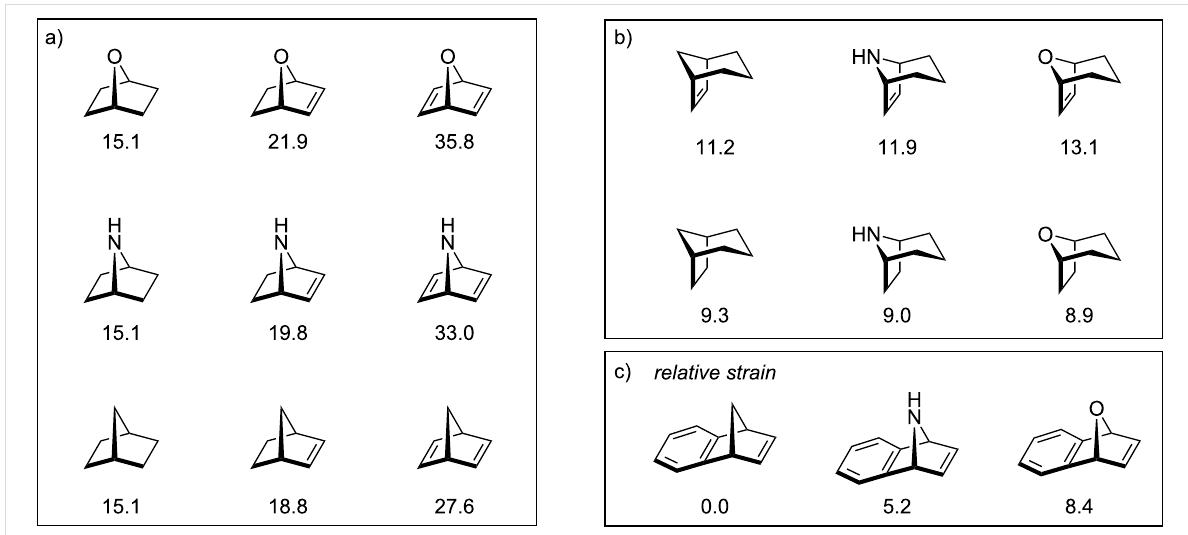
energy. Moreover, the introduction of a bridging heteroatom in- creases the ring-strain energy of the system, conceptualized by the decrease in bond distances. Typically, there are two modes for ring-strain release. First, functionalization of the double bond mildly alleviates the ring strain by relieving nonoptimal bond angles enforced by the rigid bicyclic framework. Second- ly, through ring opening of the bicyclic framework; the C–X bond of a heterobicyclic alkene is much weaker than the corre- sponding C–C bond of a homobicyclic alkene, which allows the C–X bond to be readily cleaved over the course of a reaction. The stereochemically well-defined and rigid nature of these bicyclic alkenes creates two diastereotopic faces, namely the endo and exo face (Figure 2). The exo face is sterically less congested than the endo face; therefore, the exo face will typi- cally interact with metal catalysts through side-on coordination of the olefin, and in the case of heterobicyclic alkenes, the heteroatom. This preferential exo coordination is not always the case, as norbornadiene derivatives are known to preferentially form chelated endo complexes which can change the stereo-